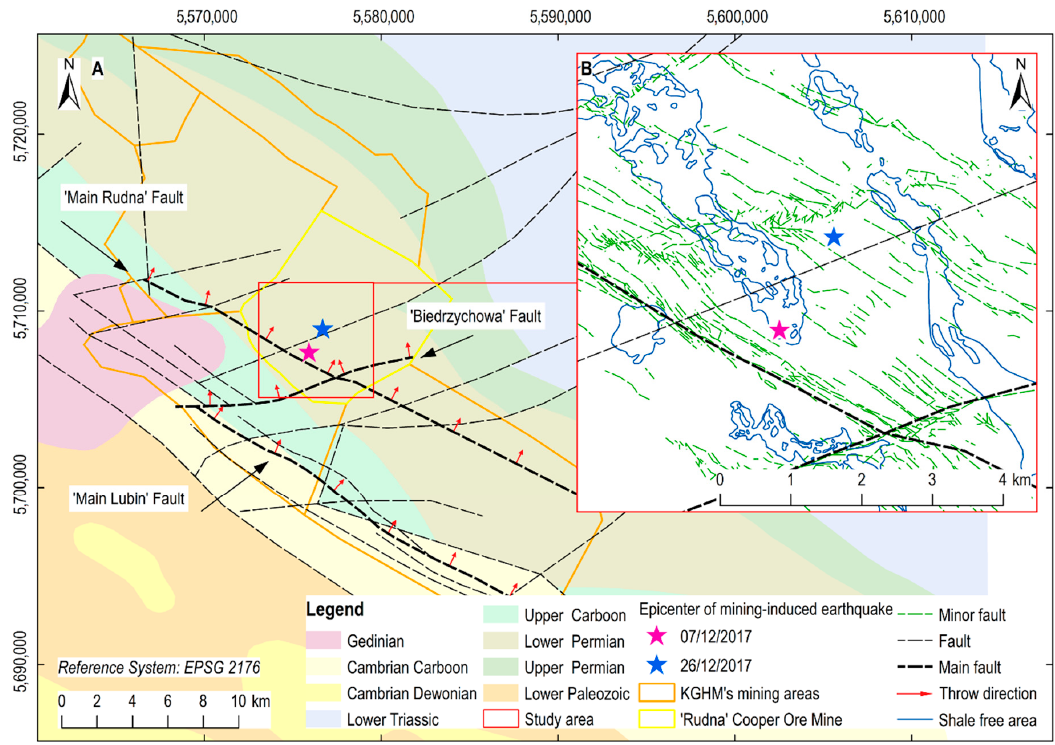
Figure 3. ( A ) Geological conditions in the analyzed area at the shearing level of 1000 m; ( B ) minor faults and shale-free areas in the Zechstein formation above mine workings, according to [15,16]. The geological-tectonic conditions in the investigated area are complex. There are numerous displacement zones. The origin of displacement zones relates to various stages of sedimentation and rock mass movements. The fault zones in that area have northwestern to southeastern course. The inclination of the main faults is from 30° to 90°. Among these fault systems the most significant ones are the “Main Rudna” fault, “Biedrzychowa” fault, and “Main Lubin” fault (Figure 3A,B; [15,17–21]). Vertical displacements along the fault plains result in higher strains in the rock masses at considerable depth. They have the form of multilevel and multidirectional microfractures. A variety of interlayer strains on the boundary of the Lower and Upper Permian may be observed. There are